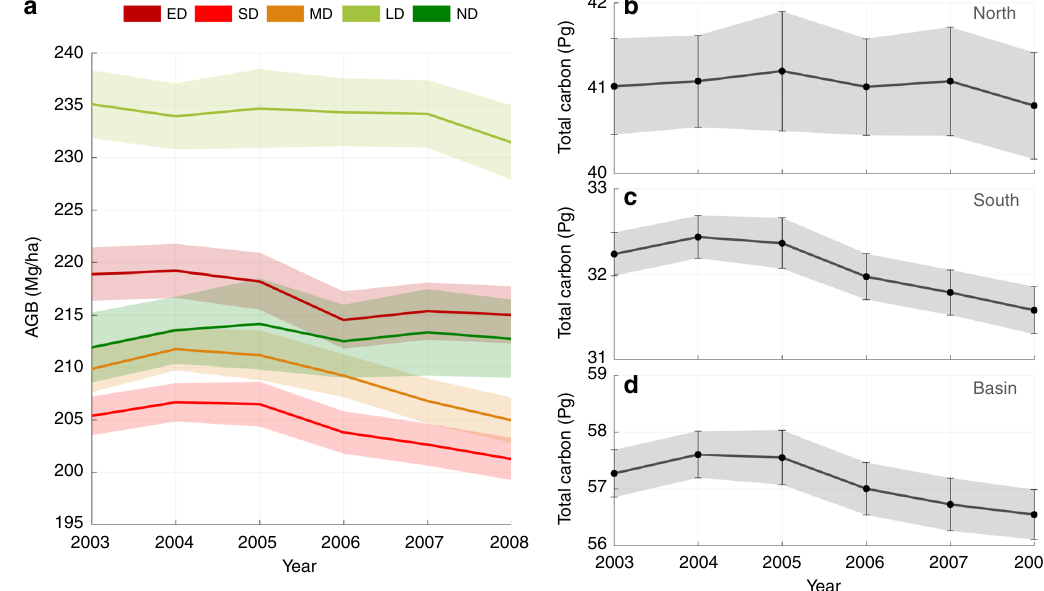
Fig. 2 GLAS-derived biomass changes in Amazon. a Interannual above ground biomass (AGB) changes of regional means in fi ve climatic regions (see Fig. 1a); b Interannual total carbon changes in North; c Interannual total carbon changes in South; d Interannual total carbon changes over the Amazon basin. The error bars (shaded area) stand for 95% con fi dence intervals. We combine regions LD and ND to be North, and regions ED, SD, and MD as South. The abbreviations ED, SD, MD, LD, and ND are regions of extreme drought, severe drought, moderate drought, light drought and no drought. All estimations in this fi gure were derived from the spatial modeling with fi lled data gaps (SMF) method (see